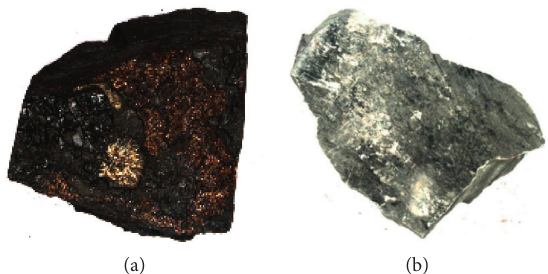
Figure 4: Images of different types of gangues. (a) Lignitous coal gangue Sample. (b) Bituminous coal gangue